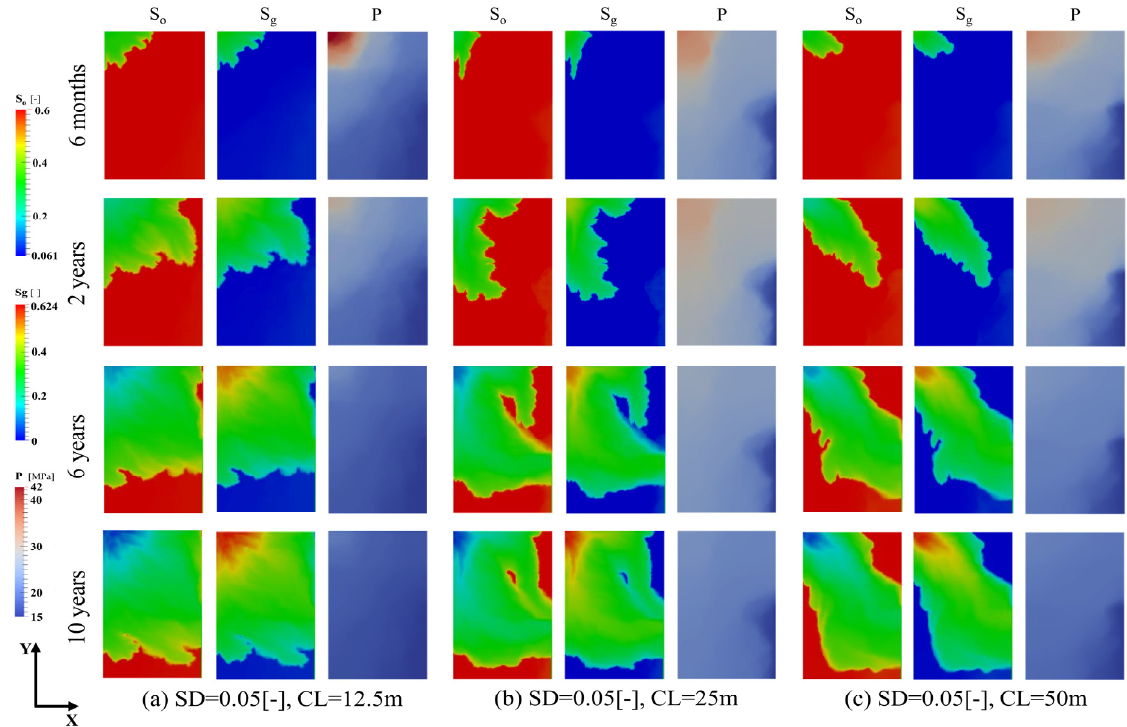
Figure 8. Evolutions of saturation and reservoir pressure fields in Set 2. ( a ) SD = 0.05 (-), CL = 12.5 m; ( b ) SD = 0.05 (-), CL = 25 m; ( c ) SD = 0.05 (-), CL = 50 m.